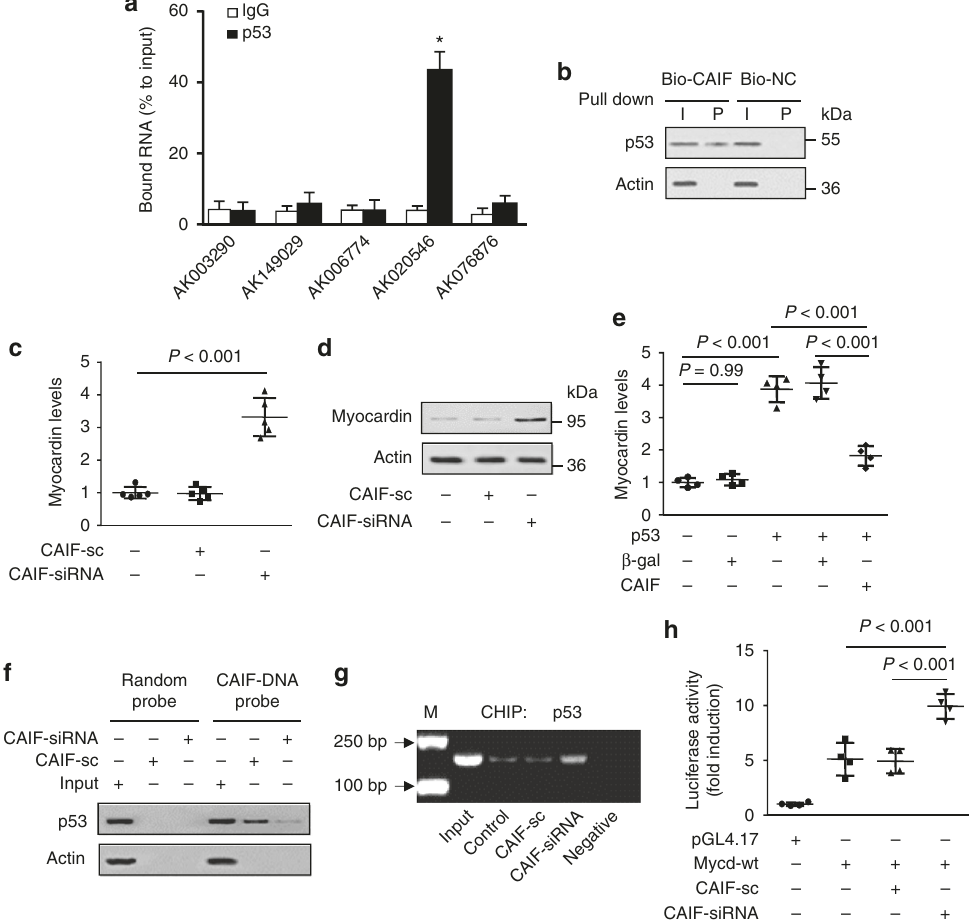
Fig. 4 CAIF binds to p53 and blocks p53-mediated myocardin transcription. a The qRT-PCR showing lncRNA enrichment by an anti-p53 antibody. Cardiomyocytes were subjected to RIP assay using an anti-p53 antibody or IgG. IP-enriched RNA was then analyzed by qRT-PCR. n = 4. b Western blot showing p53 protein interaction with CAIF. RNA pull-down assay was performed in cardiomyocytes using biotin-labeled CAIF probe (Bio-CAIF) and negative control probe (Bio-NC). c , d Knockdown of CAIF increases myocardin expression. Cardiomyocytes were infected with adenovirus CAIF-siRNA or CAIF-sc. Myocardin mRNA levels were analyzed by qRT-PCR ( c ). n = 5. Myocardin protein levels were analyzed by western blot ( d ). e CAIF inhibits p53- mediated myocardin expression. Cardiomyocytes were infected with adenovirus p53, CAIF or β -gal. Forty-eight hours after infection myocardin levels were analyzed by qRT-PCR. n = 4. f Knockdown of CAIF decreases its interaction with p53. Cardiomyocytes were infected with adenovirus CAIF-siRNA or CAIF- sc. Forty-eight hours after infection RNA pull-down assay was performed and p53 protein was detected by western blot. g CAIF knockdown enhances the binding of p53 to the promoter of myocardin. Cardiomyocytes were infected with adenovirus CAIF-siRNA or CAIF-sc. Forty-eight hours after infection CHIP was performed with p53 antibody. h Knockdown of CAIF causes the increase of myocardin transcriptional activity. Cardiomyocytes were treated with the adenoviral CAIF-siRNA or CAIF-sc, the constructs of the empty vector (pGL-4.17) and the wild-type myocardin promoter (Mycd-wt). Luciferase activity was assayed. n =